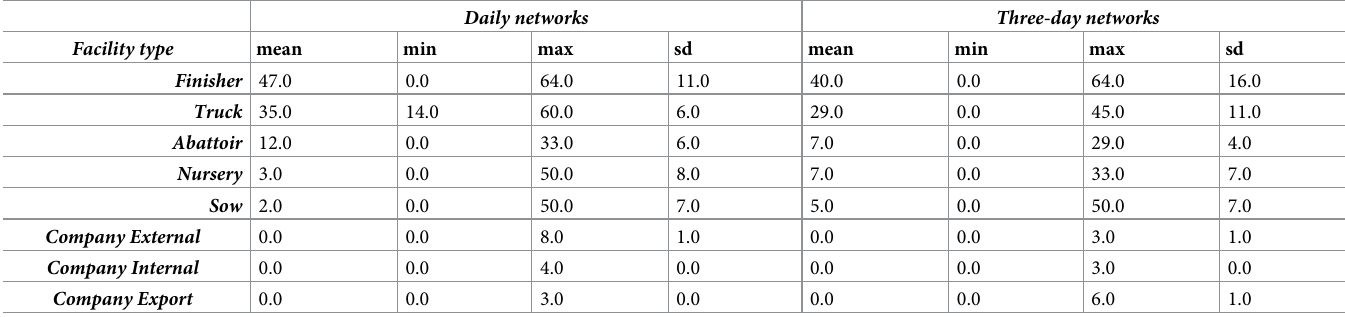
Table 2. Proportional representation of each facility type in the maximum weak component obtained from daily and 3-day 2-mode networks over the entire 2015, expressed as descriptive statistics of the percent of each facility type in the maximum weak component. Daily